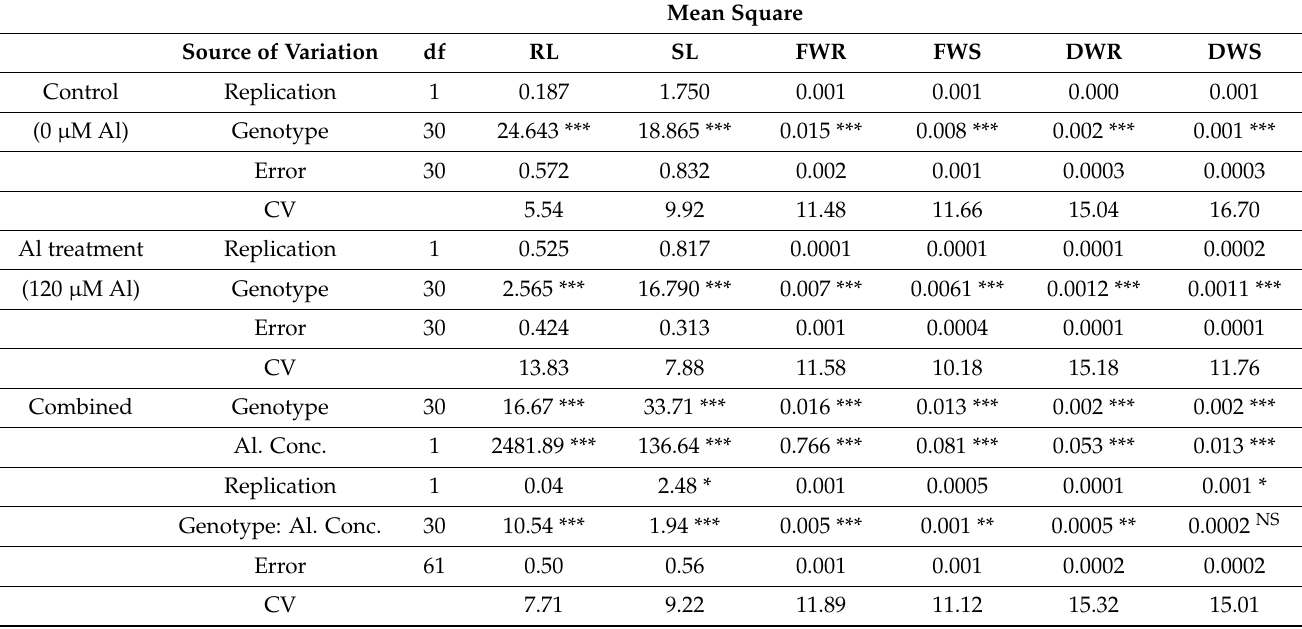
Table 4. Separate and combined analysis of variance (ANOVA) for chickpea genotypes evaluated under control (0 µ M Al) and Al treatment (120 µ M Al) conditions. Mean